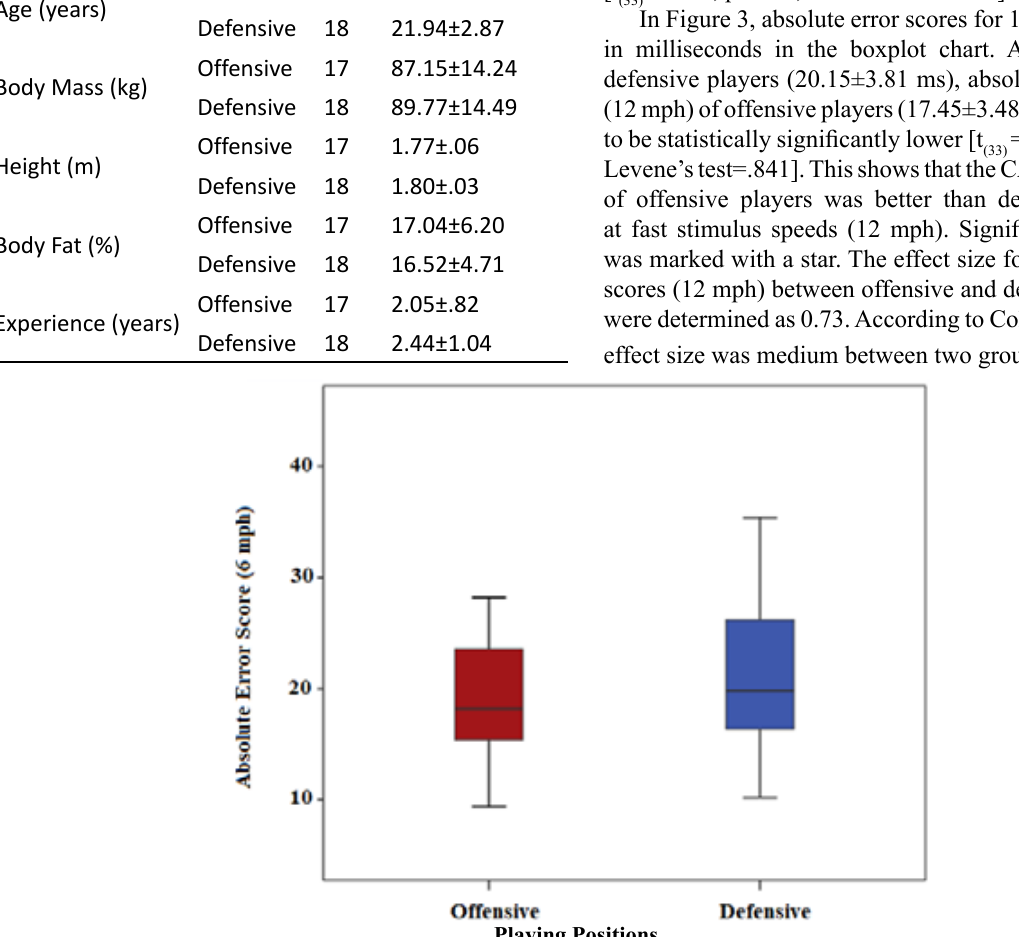
Figure 2. Comparison of Absolute Error Scores (6 mph) of American football players accroding to playing positions